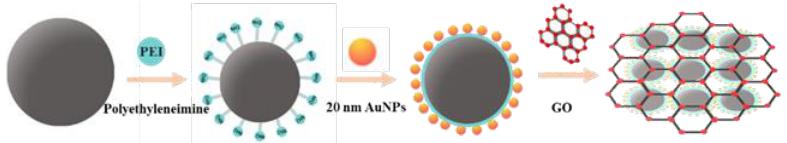
Figure 1. Schematic diagram of GO/Fe 3 O 4 @Au magnetic SERS substrate.